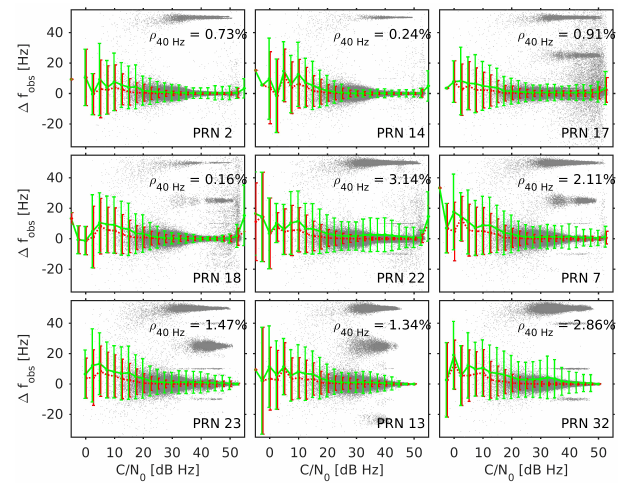
Figure 14. Same as Fig. 9, however, showing the difference be- tween the two observed frequencies obtained from O/L channel A and B as a function of the mean signal-to-noise density ratio (Eq. 11). Mean and 1 σ standard deviations, calculated from C /N 0 bins 2 . 5dBHz wide, are marked in green. The fraction of data points exceeding (cid:49)f obs > + 40Hz is indicated as ρ 40 Hz . The re- sult of the statistical analysis excluding this subset still exhibits a positive bias if C /N 0 (cid:46) 30dBHz (red).